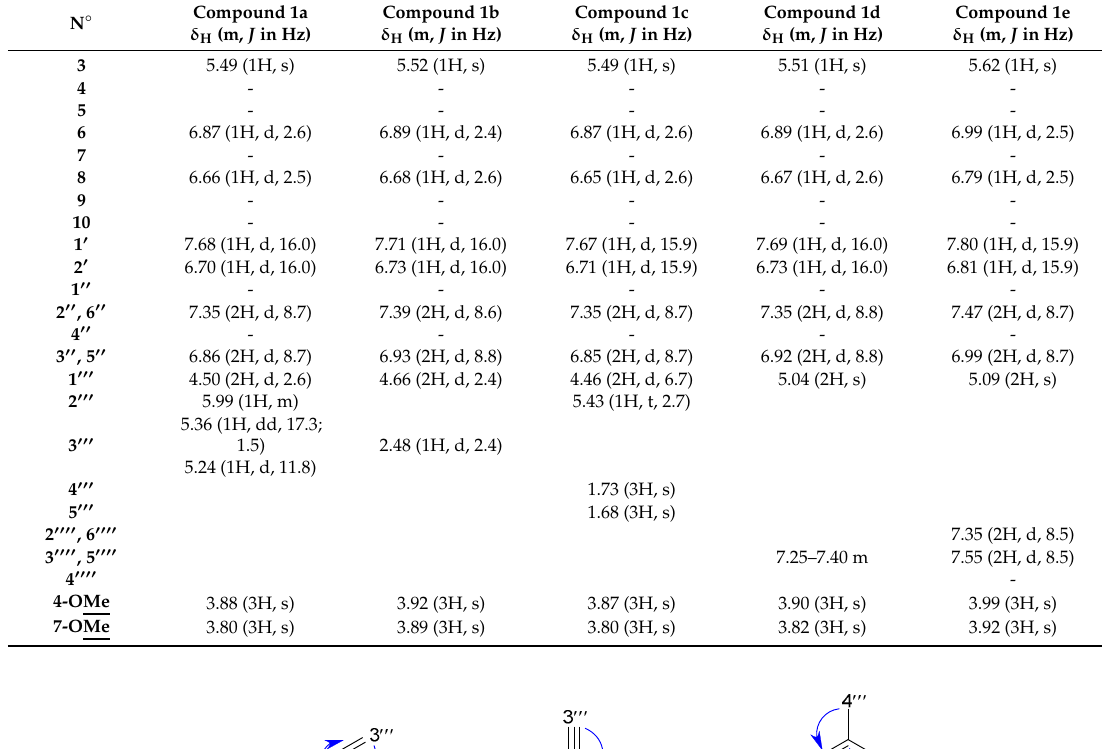
Table 2. 1 H NMR data of compounds 1a – e [CDCl 3 ; 500 MHz].